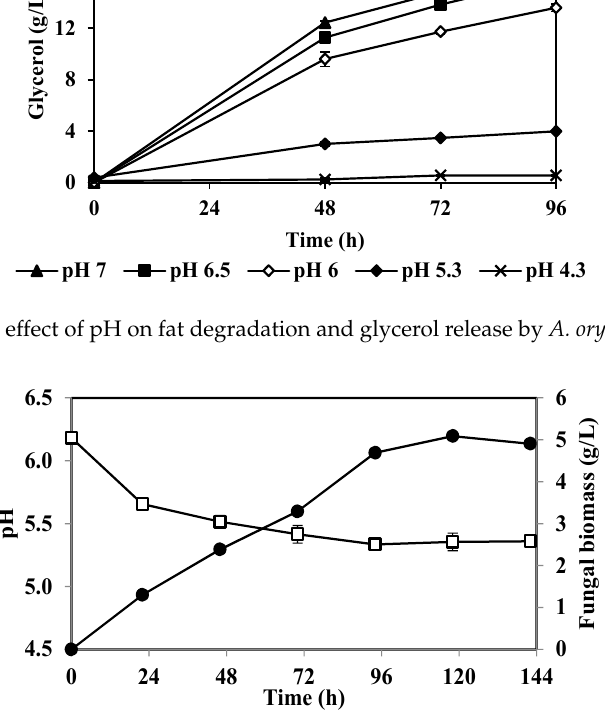
Figure 2. The trend of change in pH ( □ ) and biomass ( ● ) concentration in the medium containing cream and A. oryzae .